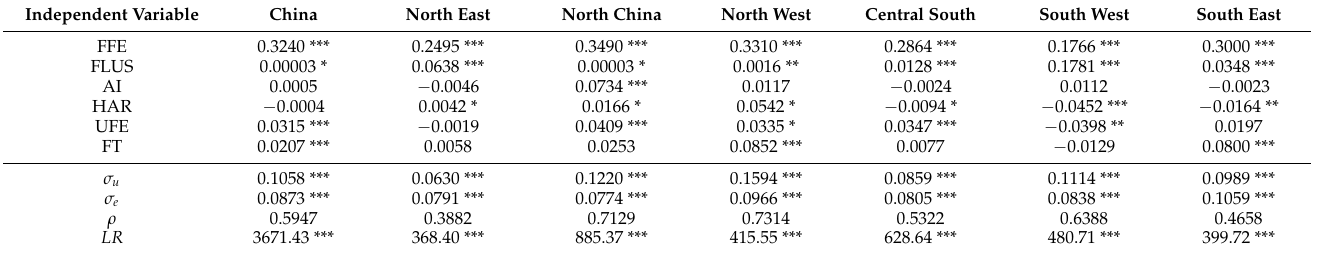
Table 6. Estimated results of influencing factors of internal operating behavior in different regions.